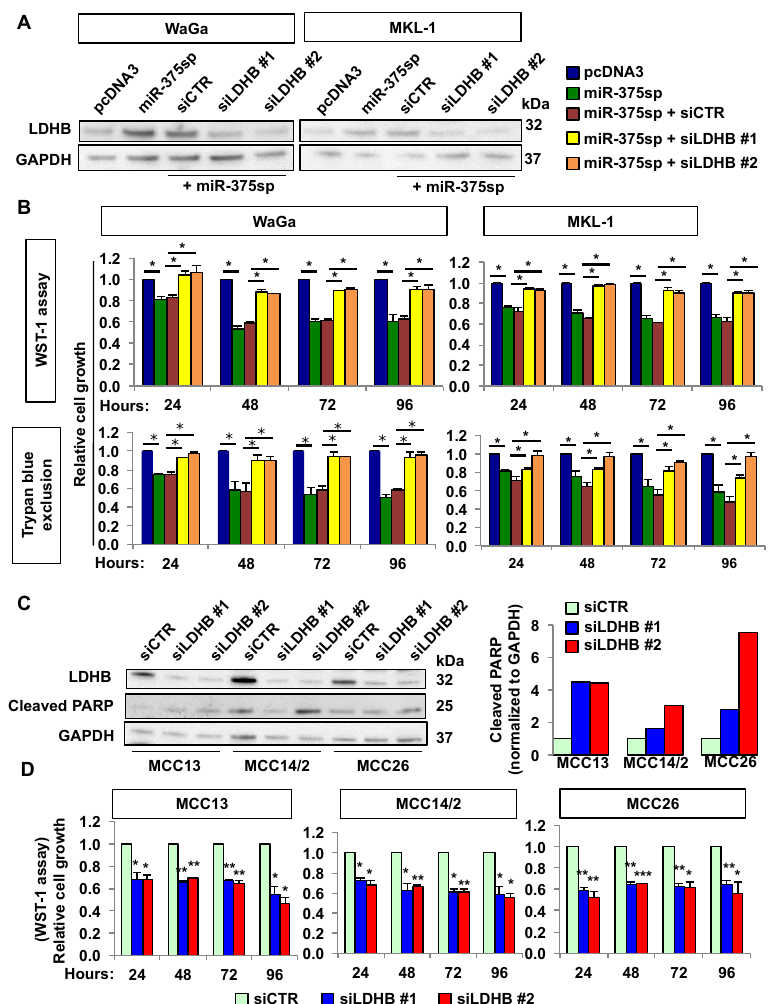
Figure 6. LDHB plays dual roles in MCPyV+ and MCPyV− MCC cells. ( A , B ) MCPyV+ MCC cell lines were transfected with miR-375sp or pcDNA3, or co-transfected with miR-375sp together with siCTR, siLDHB #1, or siLDHB #2. ( A ) Western blot analysis of LDHB in the transfected cells after 72 h of transfection. GAPDH was used as a loading control. ( B ) The effect on cell growth was evaluated at different time points using WST-1 and trypan blue exclusion assays. ( C , D ) MCPyV− MCC cell lines were transfected with siCTR, siLDHB #1, or siLDHB #2 for 48 h. ( C ) Western blot analysis of the effect of LDHB silencing on LDHB protein level and cleaved PARP. The specific 25 kDa cleaved form of PARP was detected using anti-cleaved PARP antibody (Abcam). Quantification of the cleaved PARP levels is presented on the right panel. ( D ) Effect of LDHB silencing on cell growth was evaluated using WST-1 assay. Mean ± SEM (n = 3). * p < 0.05, ** p < 0.01, and *** p < 0.001 by paired Student’s t -test.